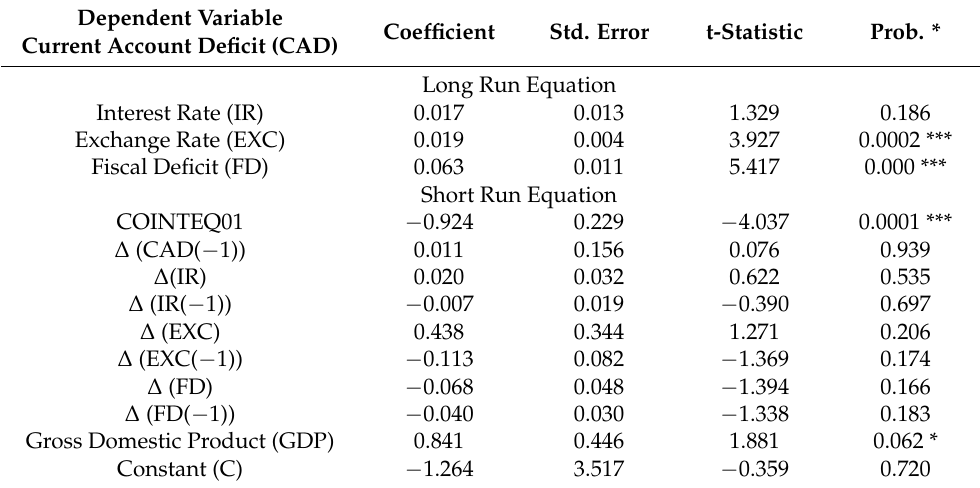
Table 5. Results of auto-regressive distributed lag (ARDL) for long-run and short-run